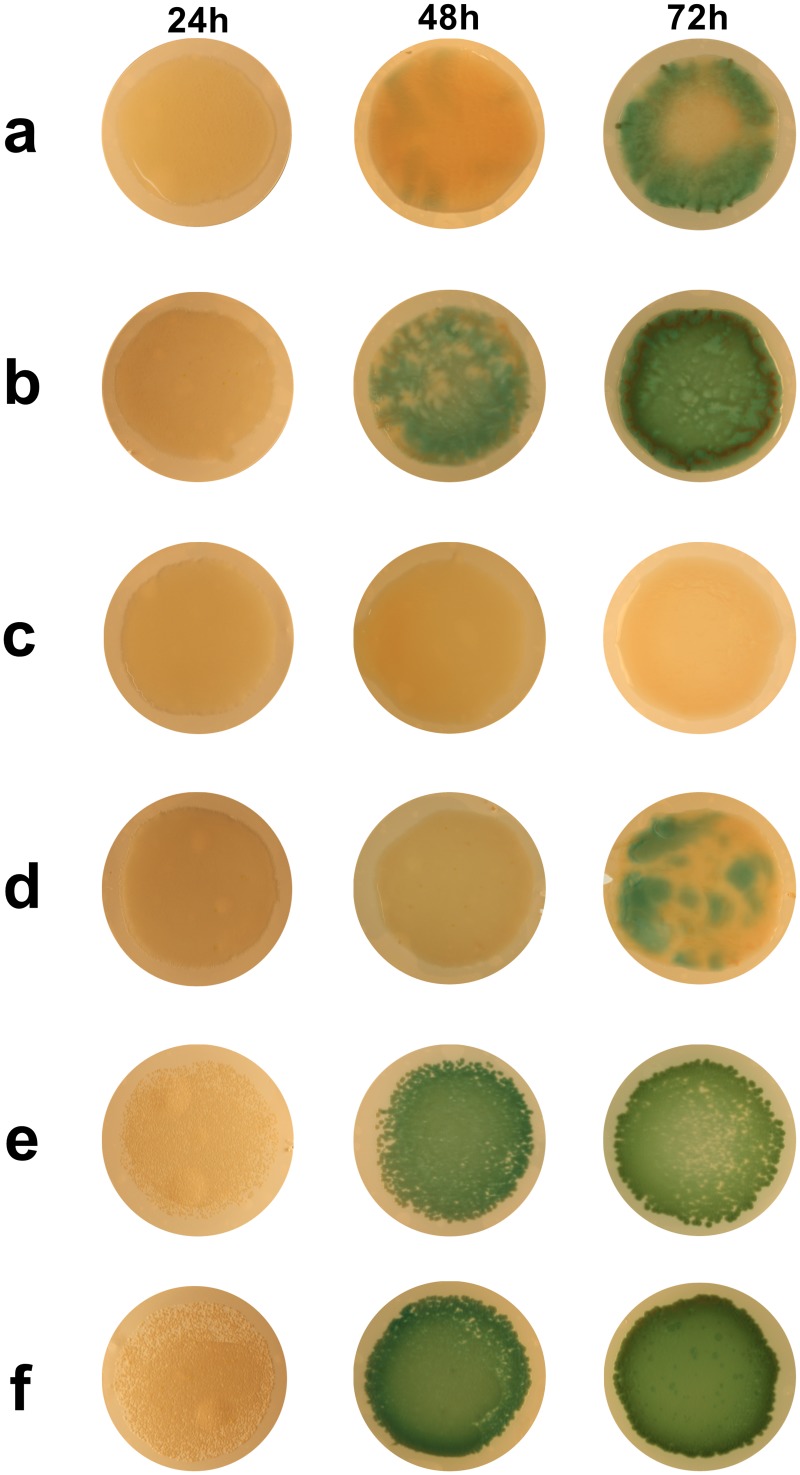
Interactions of colony phenotypes DWW2, DWW2-M and DWW2-NM with S. anginosus strain 3a.(A) Co-culture with 3a results in increased pyocyanin expression by the original strain DWW2 (black bars) (n = 3 independent biofilms at 48 h) and by the mucoid (DWW2-M) (white bars) (n = 6 independent biofilms at 72 h) and non-mucoid (DWW2-NM) (grey bars) (n = 6 independent biofilms at 48 h) biofilm-derived colony phenotypes. Extracted pyocyanin from DWW2-NM and DWW2-NM+3a were assayed at x0.5 original concentration to enable accurate determinations. Data values are mean and SD. Statistical analysis was by 2-tailed Student T-test assuming unequal variances (* = p <0.05; ** = p<0.01). (B) Co-culture of DWW2-M and 3a gives rise again to pigmented and non-pigmented areas with the non-mucoid phenotype (DWW2-NM) predominant in the pigmented areas (DWW2-NM biofilms in mono-culture or co-culture did not give rise to the DWW2-M phenotype). Data values are means and SD (n = 4 independent biofilms at 72 h). Statistical analysis of the data was by two-tailed Mann-Whitney U test. (C) Co-culturing 3a with either DWW2-M or DWW2-NM results in significantly increased numbers of 3a as observed for co-culture between 3a and the original mucoid strain DWW2. Data values are means and SD (n = 6 independent biofilms at 24 h). Statistical analysis of the data was by one-way ANOVA with Dunnet’s multiple comparison test between 3a in mono-culture (control) and co-cultures (**** = p<0.0001).